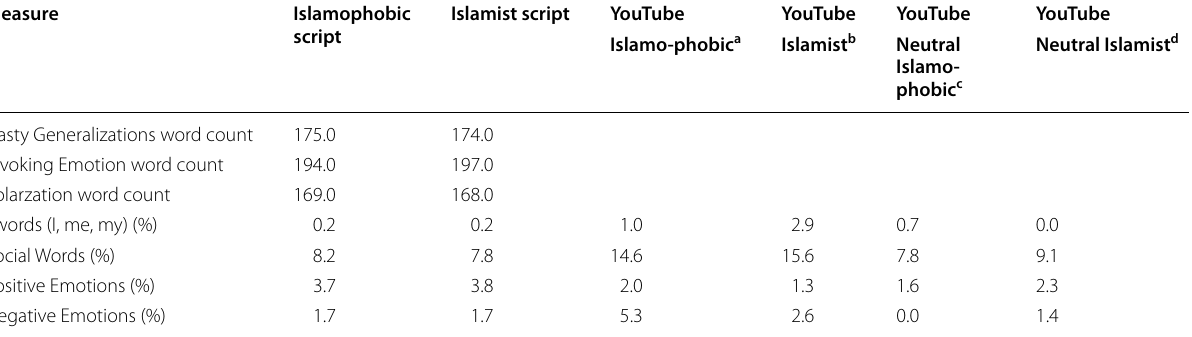
Table 2 LIWC analysis of training videos and extremist videos on